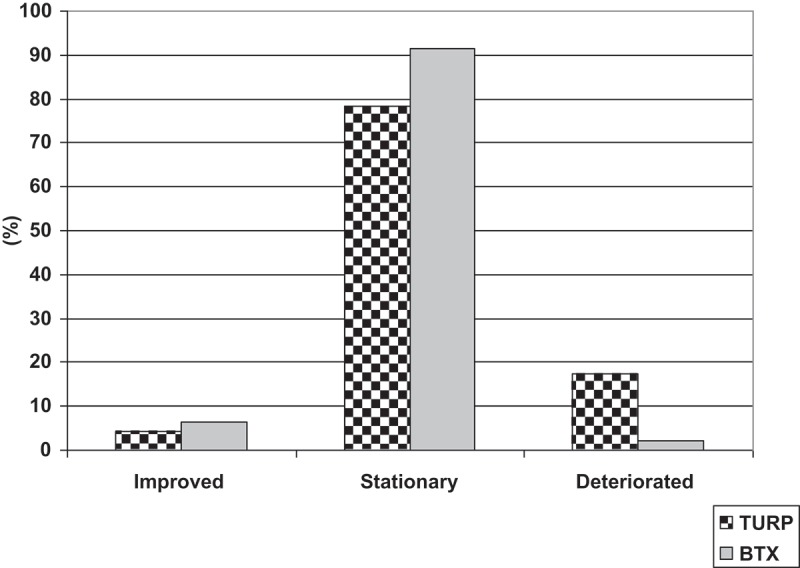
Patients’ distribution according to effect of treatment on erectile function. BTX, BoNT-A.